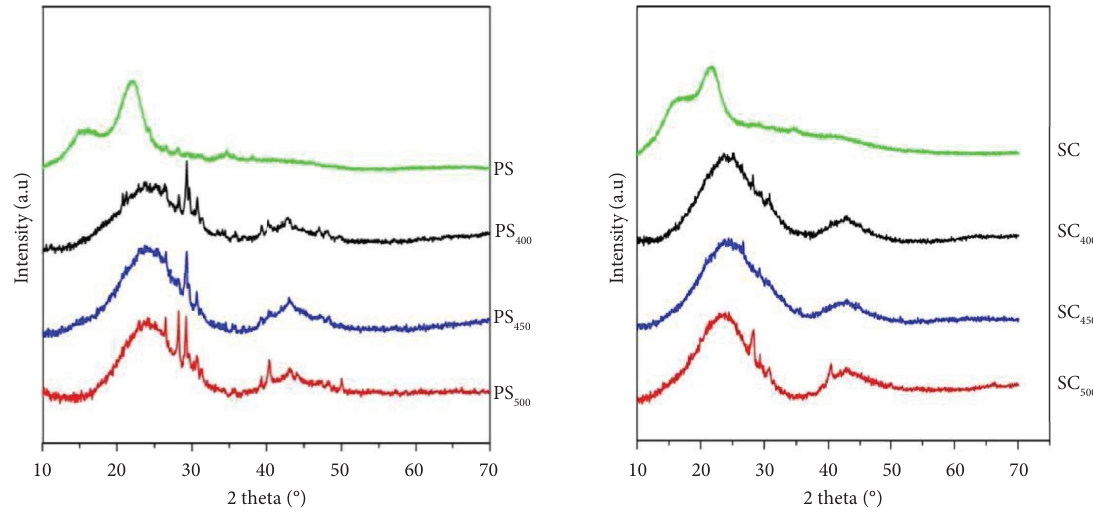
Figure 4: Difractograms of PS, PS 400 , PS 450 , PS 500 and SC, SC 400 , SC 450 , SC 500 .